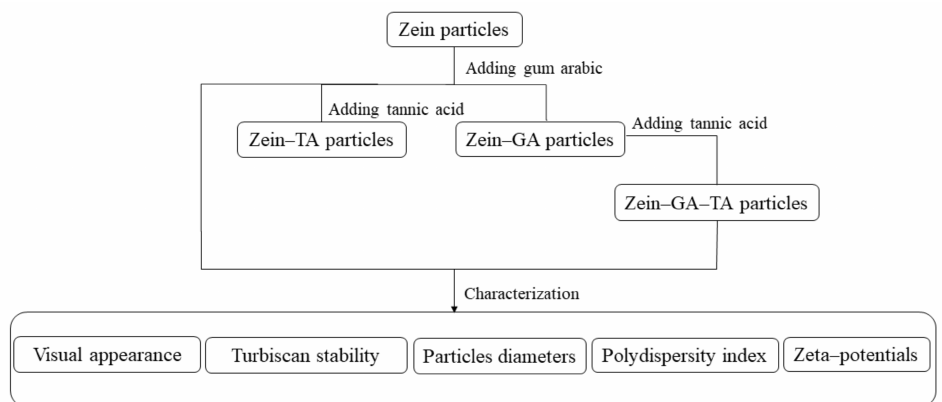
Figure 5. The preparation procedure of particles in this